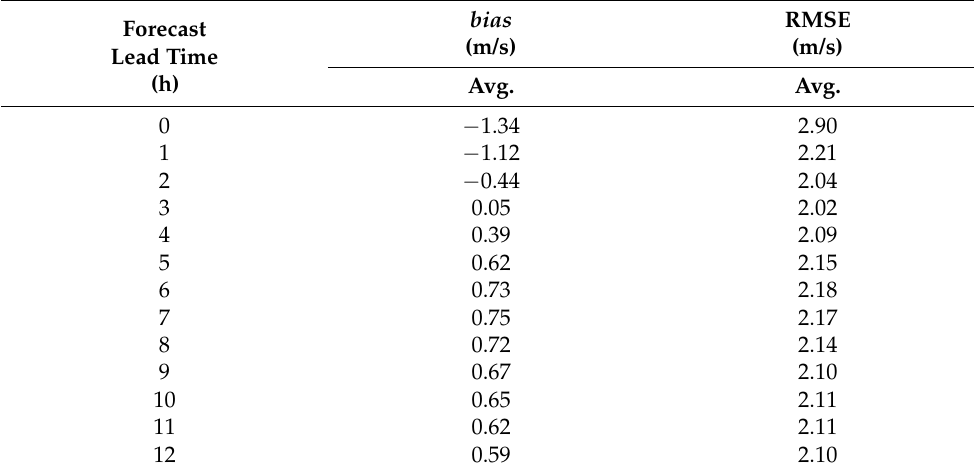
Table 2. Values of bias and root mean square error (RMSE) of sea wind data averaged over all observation